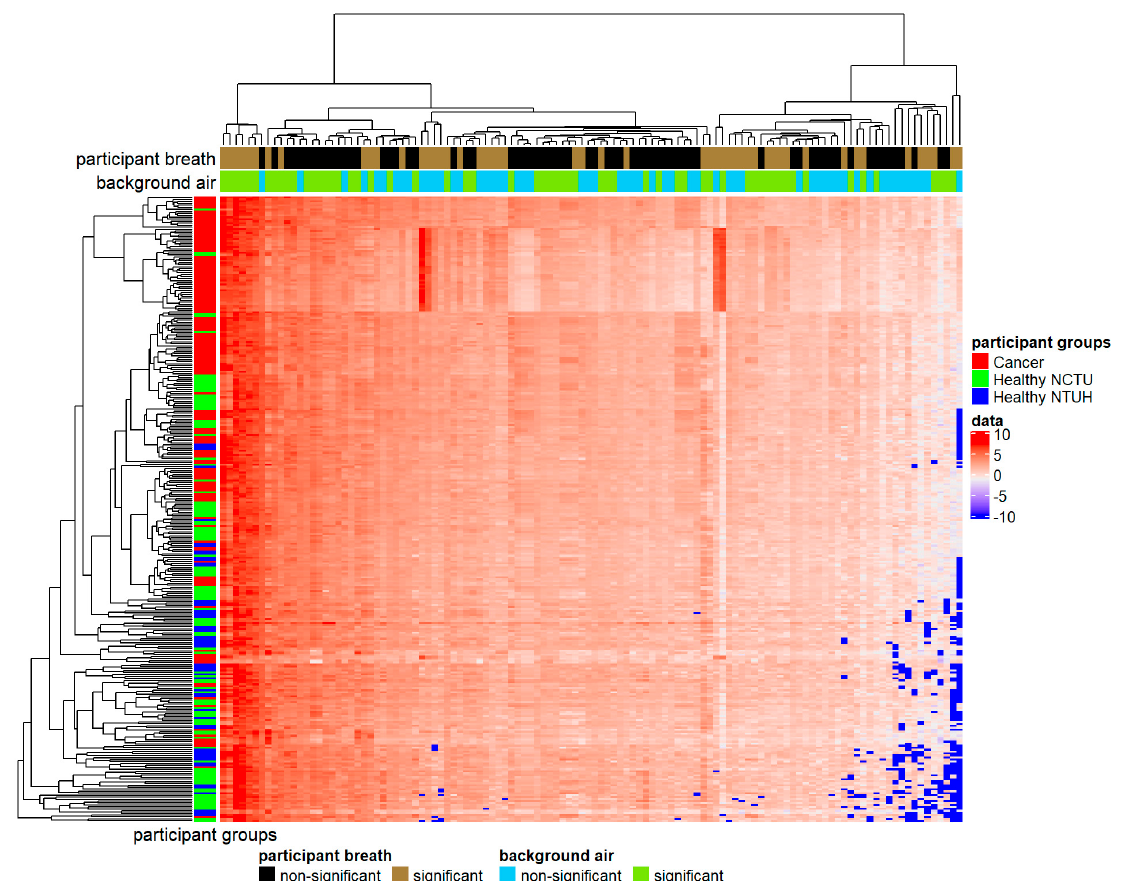
Figure 2. The heat map of 116 volatile organic compounds (VOC) measurements (log concentrations) for 316 participants. In the color matrix at the center, each row represents a participant, and each column represents a single VOC with the diverging color scheme of red (high concentration) and blue (low concentration). VOCs and participants are clustered using the agglomerative hierarchical clustering method. In the color bar on the left, red indicates cancer patients, green indicates healthy volunteers of the National Chiao Tung University (NCTU), and blue indicates healthy volunteers of the National Taiwan University Hospital Hsin-Chu Branch (NTUH). The two-color bars at the top represent the significance of VOCs. The first bar indicates whether VOCs showed significant differences between lung cancer patients and healthy controls (brown for significant and black for nonsignificant). The second bar indicates whether VOCs were significantly different between NCTU and NTUH (green for significantly different and blue for not significantly different).